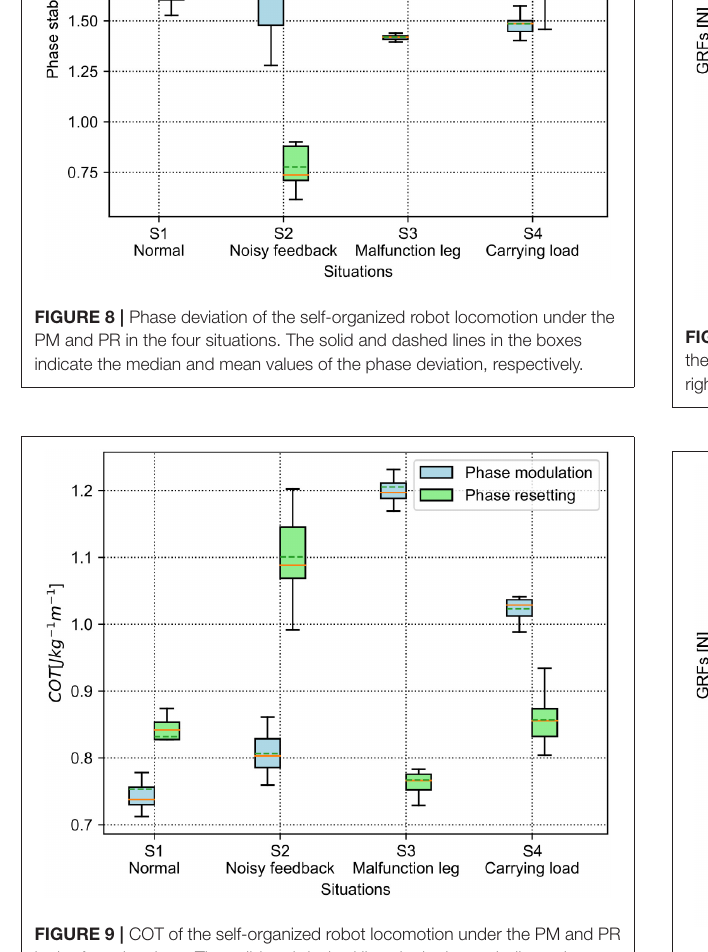
FIGURE 11 | GRF distribution of the self-organized robot locomotion under the PR in the four situations. Note that RF, RH, LF, and LH indicate the right front, right hind, left front, and left hind legs,